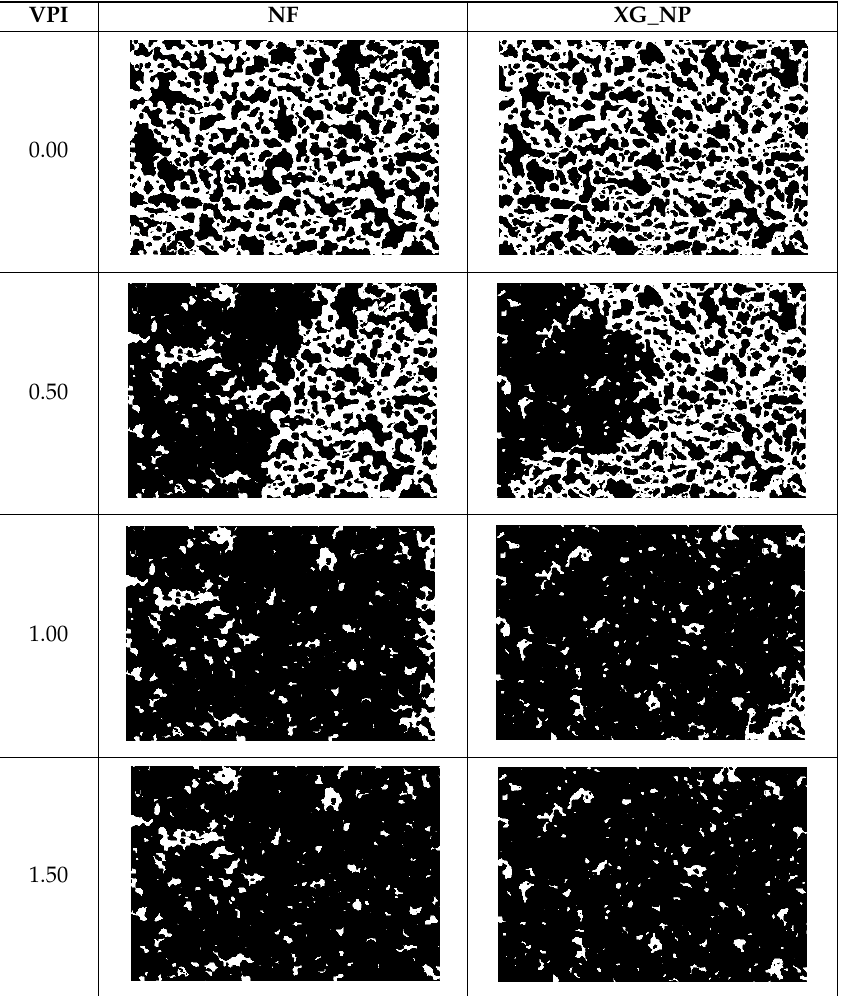
Table A2. Images segmented of the evaluation of the silica NPs in the polymer flooding in the function of the porous volume injected (PVI) during the recovery agent injection. This part shows the reference nanofluid (NF) and the xanthan gum with NPs (XG_NP). Due to different injection problems, the Scleroglucan with NPs was unsuccessful.